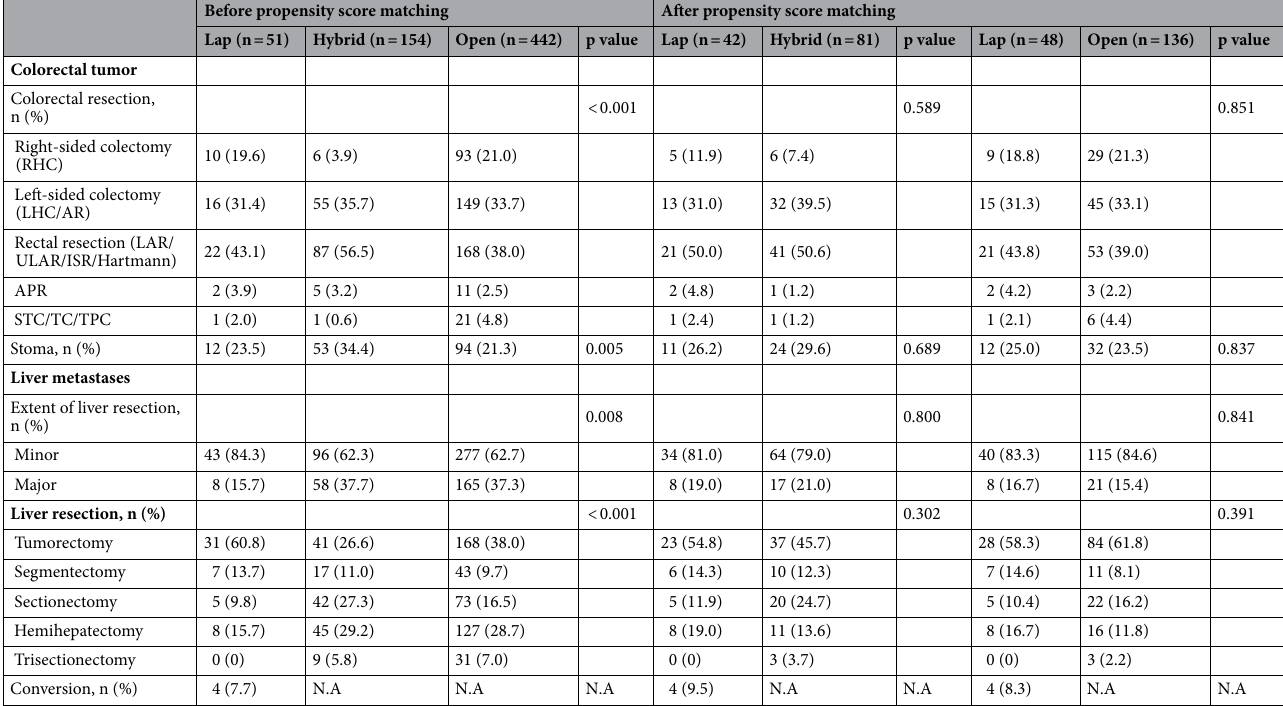
Table 2. Surgical characteristics according to treatment group. Lap, laparoscopic; RHC, right hemicolectomy; LHC, left hemicolectomy; AR, anterior resection; LAR, low anterior resection; ULAR, ultralow anterior resection; ISR, intersphincteric resection; APR, abdominoperineal resection; STC, subtotal colectomy; TC, total colectomy; TPC, total proctocolectomy; N.A., not